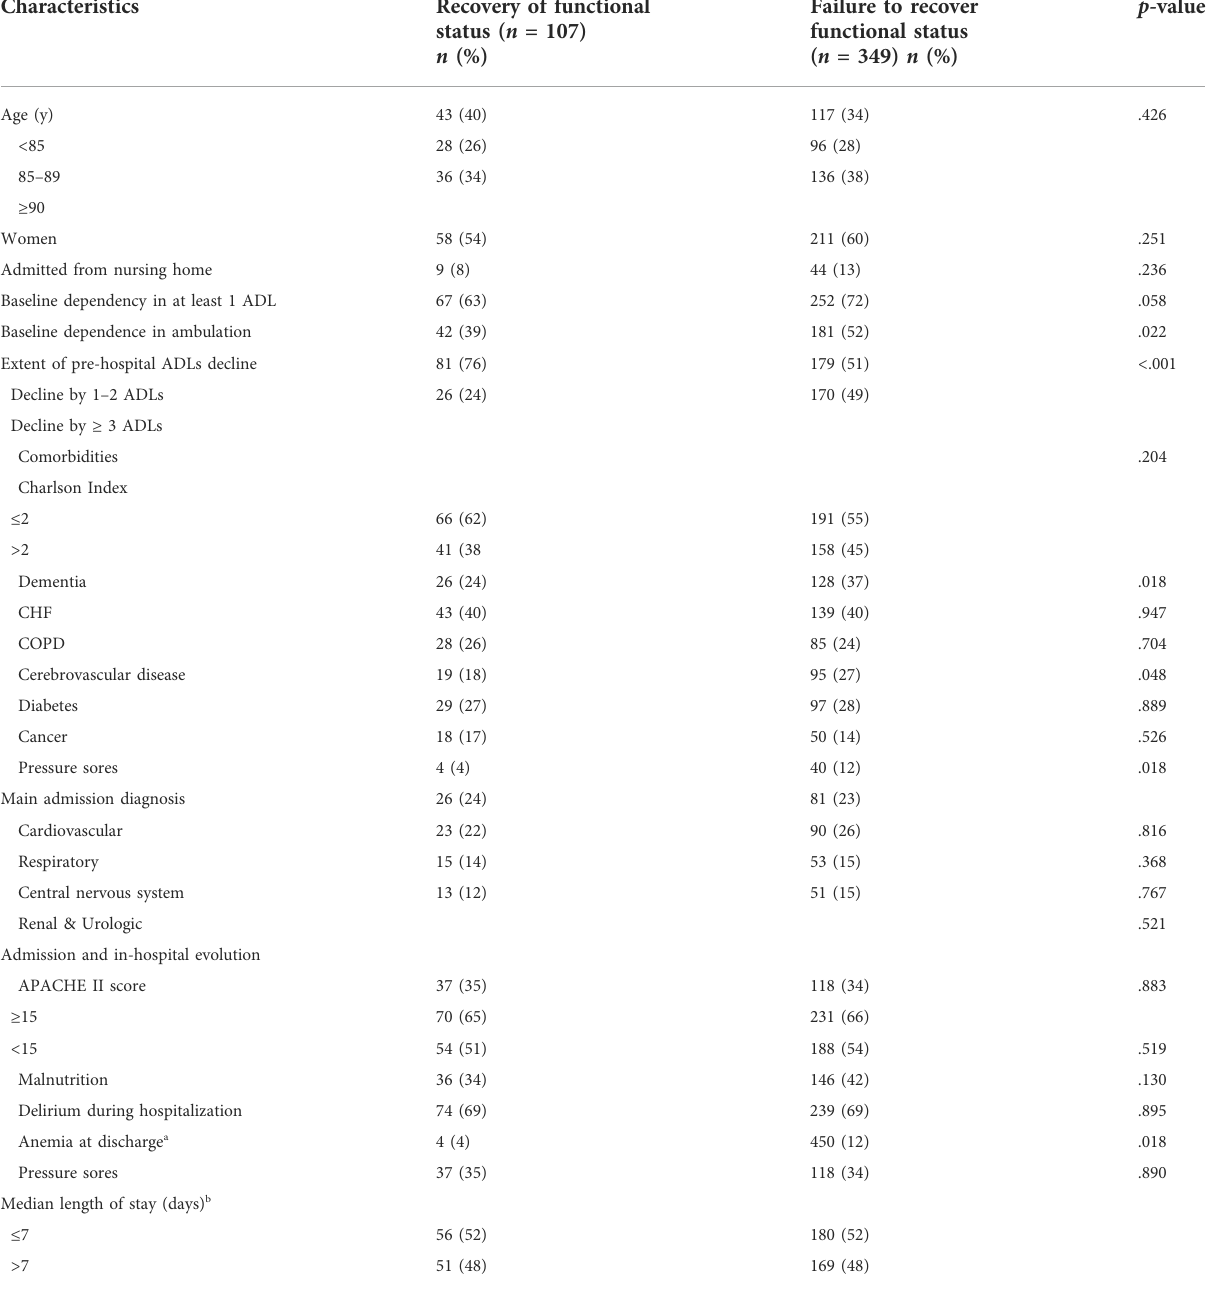
TABLE 2 Characteristics of participants with pre-hospital decline (N = 456) according to recovery or failure to recover baseline functional status by hospital